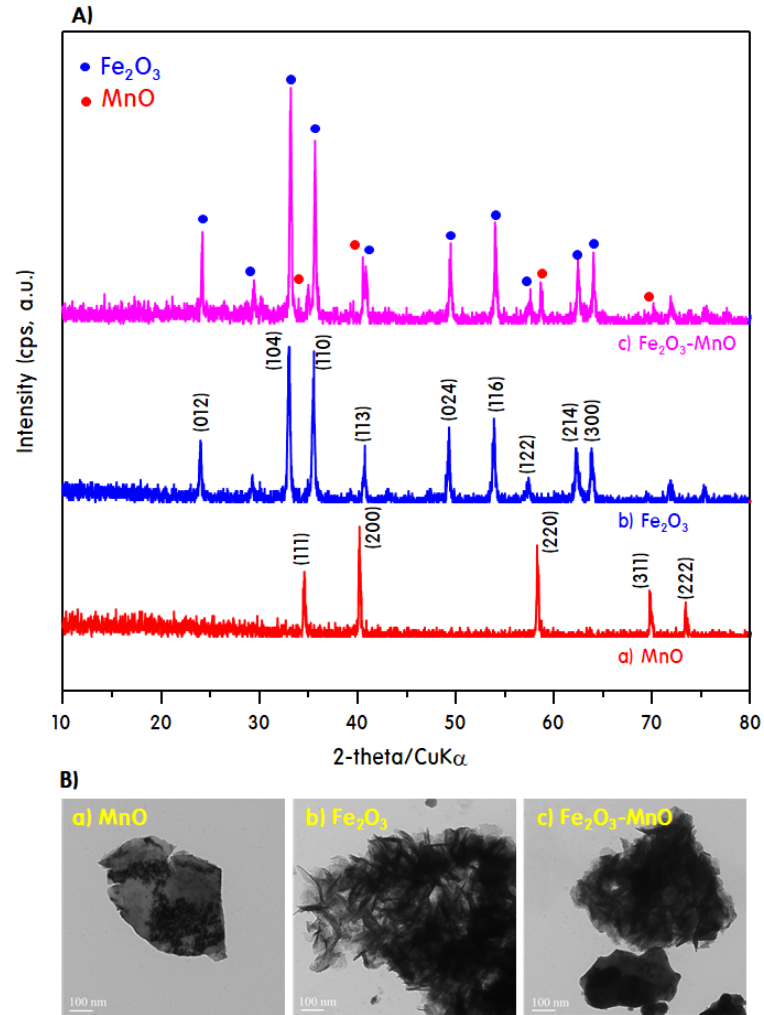
Figure 1. X-ray diffraction (XRD) patterns ( A ) and transmission electron microscopy (TEM) images ( B ) of the powder particles before the electrode assembly.